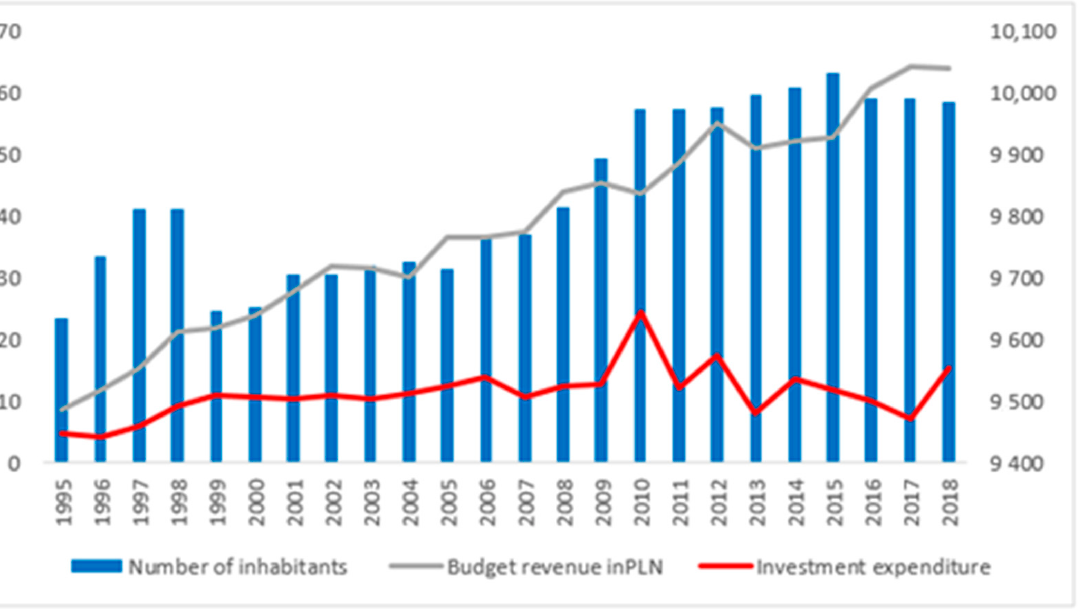
Figure 11. Budget revenue, investment expenditure (in millions of PLN), and population of the Kleczew municipality in 1995–2018 (Source: own elaboration based on data from the Central Statistical Office).